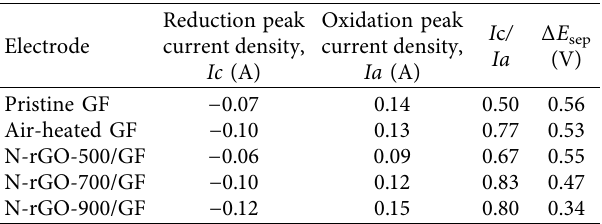
Figure 7: CV spectra of N-rGO-modified GF electrodes at a scan rate of 5mV/s in the applied voltage range from 0 V to 1.6 V. Table 4: Electrochemical parameters for samples studied obtained from